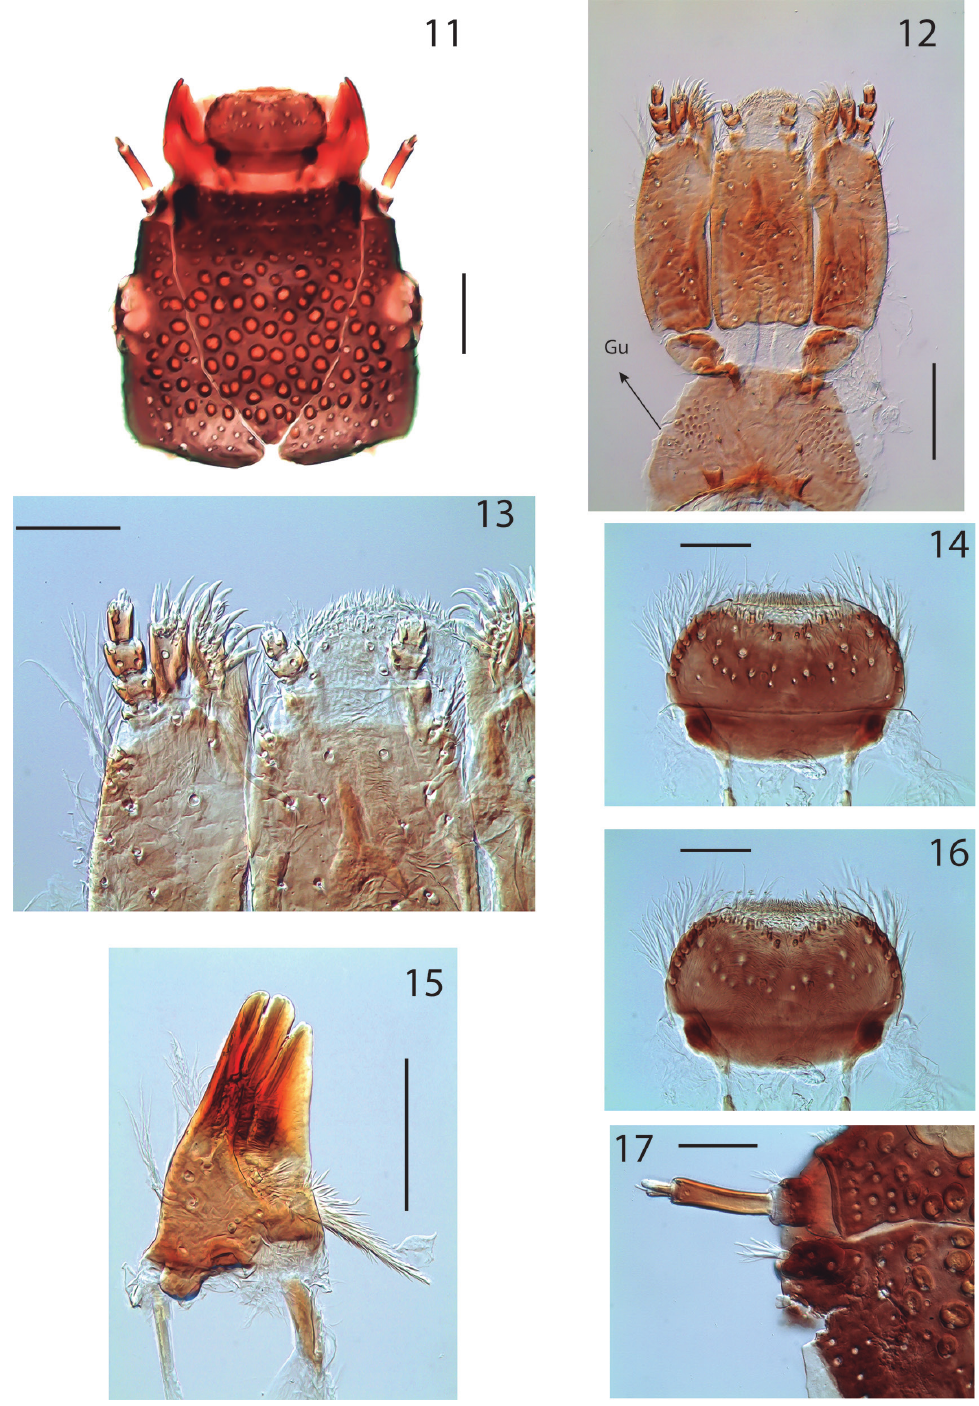
Figures 11–17 - Stethemis shepardi mature larva. ( 11 ) head capsule, dorsal view; ( 12 ) maxillo–labial complex and gula, ventral view; ( 13 ) detail of maxillo–labial complex showing distal end of right maxilla and labium; ( 14 ) labrum, dorsal view; ( 15 ) left mandible, dorsolateral view; ( 16 ); labrum, ventral view; ( 17 ) antennae, dorsal view. Scale bars: Figs. 11–12, 15: 0.10 mm; Figs. 13–14, 16–17: 0.05 mm . Abbreviation: gu-